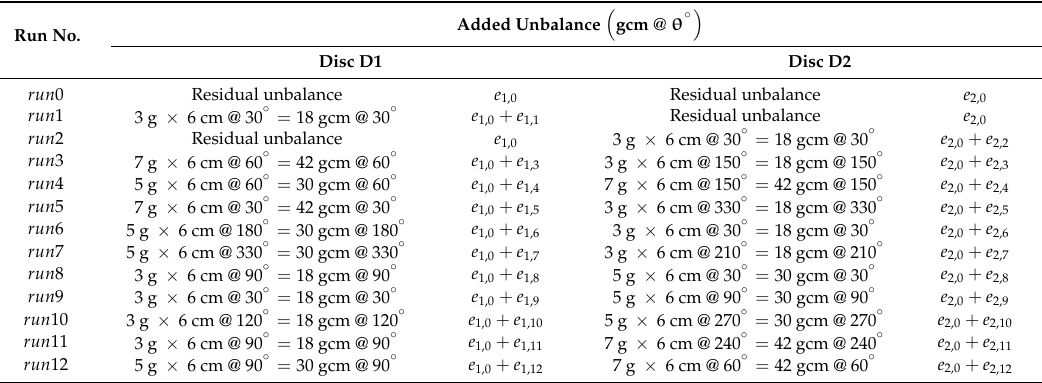
Figure 2. Mode shapes of the test rig: ( a ) first mode; ( b ) second mode, ( c ) third mode and ( d ) fourth mode. ( d ) fourth mode. Table 2. Mass unbalances and phase angles of 13